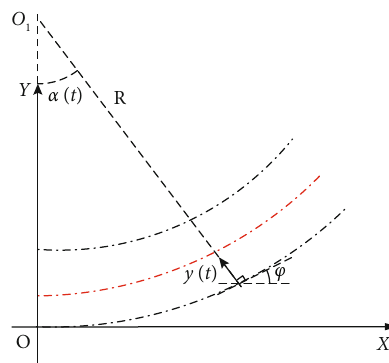
Figure 2: Schematic diagram of lane-changing tracking